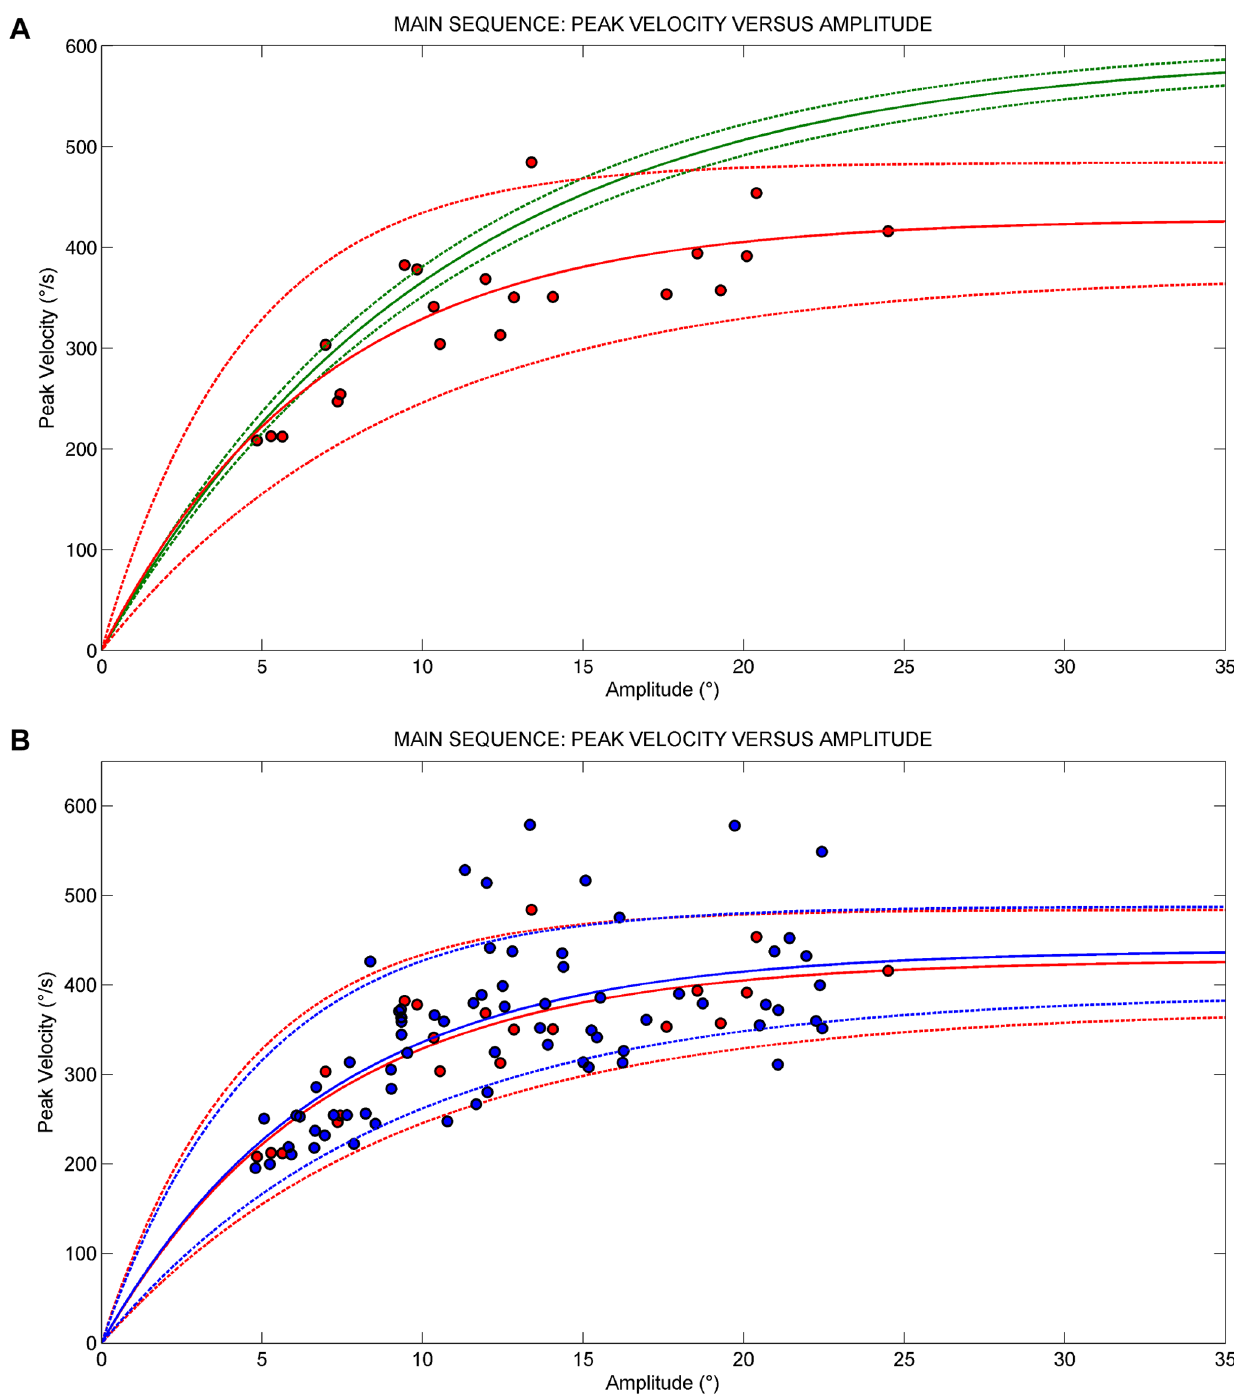
Figure 4. Plot of Main Sequence relationships. A) Red data points are saccades of patients (filled red circle). The red curves were fitted to the respective data; the green curves fitted the controls data (data points not shown). B) Data points are saccades of patients pre-therapy (filled red circle), and patients post-therapy (filled blue circle). The colored curves were fitted to the respective data. The data were fitted using the exponential equation V peak =V max [1 2 e ( 2 amplitude/C) ], where V max is asymptotic peak velocity and C is the angle constant shaping the exponential rise. The 95% prediction bounds for healthy subjects are indicated (broken curve).